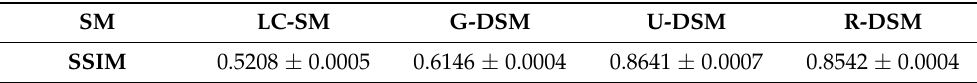
Table 3. SSIM (mean ± SD) with FC-SM of LC-SMs, G-DSMs, U-DSMs, and R-DSMs for 137